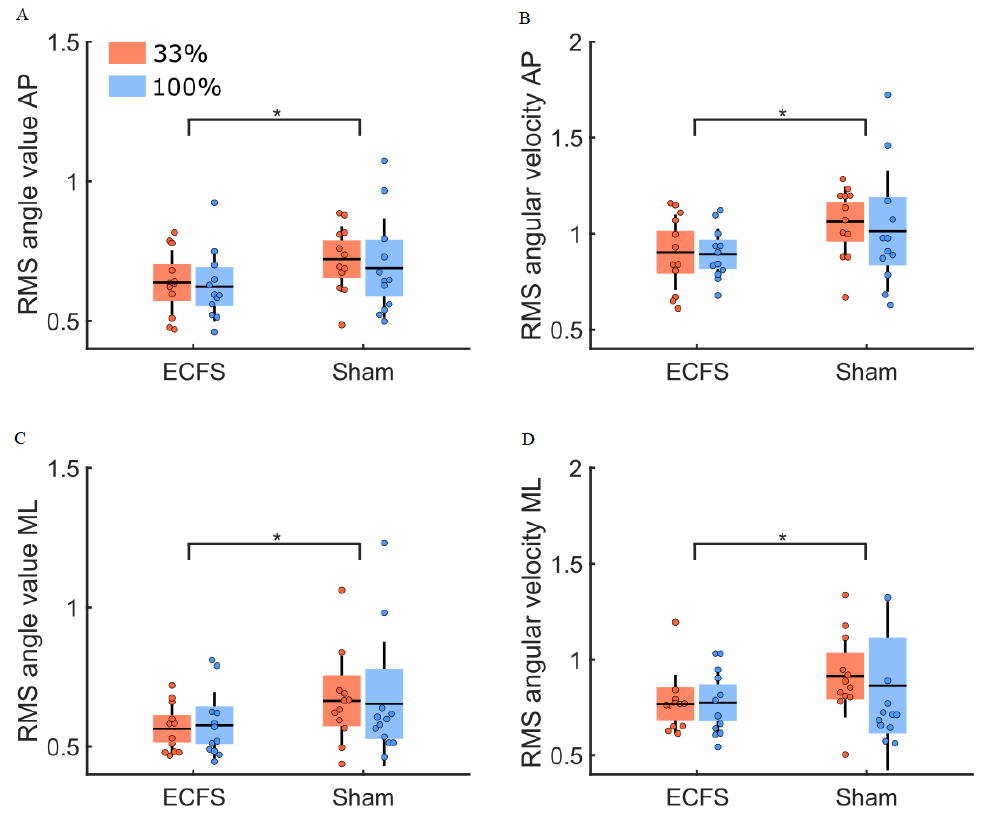
Figure 11. RMS values for body sway angle and angular velocity for both groups (33% and 100% feedback groups, red and blue boxes, respectively) for the control condition (ECFS) and the sham condition. Panels ( A , C ) depict the RMS values of the body sway angle along the AP and ML axes. Panel ( B , D ) show the RMS values of the body sway angular velocity along the AP and ML axes. The dots represent the mean results for each participant, horizontal lines depict the group’s means, boxes represent the group’s standard error of the mean, and vertical lines, one standard deviation. The asterisks (*) indicate a significant main effect of condition. The units for the RMS values of the body sway angle and angular velocity are ( ◦ ) and ( ◦